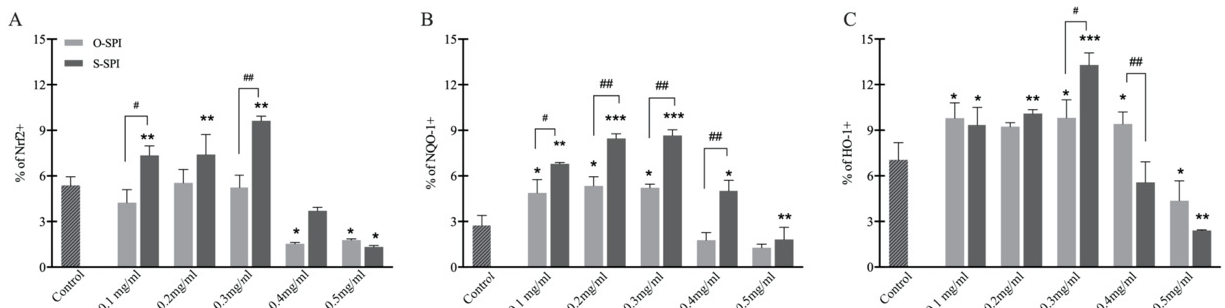
Figure 4. O 2 -induced changes in the nuclear accumulation of Nrf2 and the expression of Nrf2-related in Caco-2 cells. Flow cytometry analysis of Nrf2 ( A ), NQO-1 ( B ), and HO-1 ( C ). Values are expressed as mean ± SEM (n = 3). Significant differences between control group and other group are indicated by * p < 0.05, ** p < 0.01, *** p < 0.001. Differences between O-SPI and C-SPI under same concentration are indicated by # p < 0.05, ## p < 0.01. Differences are analyzed with a two-way analysis of variance (ANOVA) followed by a Tukey test.